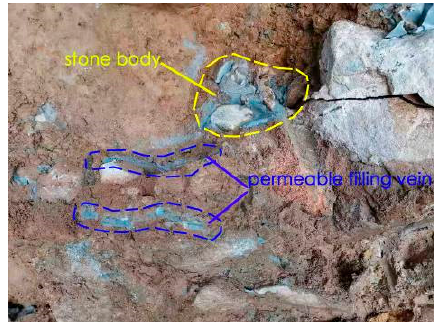
Figure 12. Slurry diffusion in the vault.